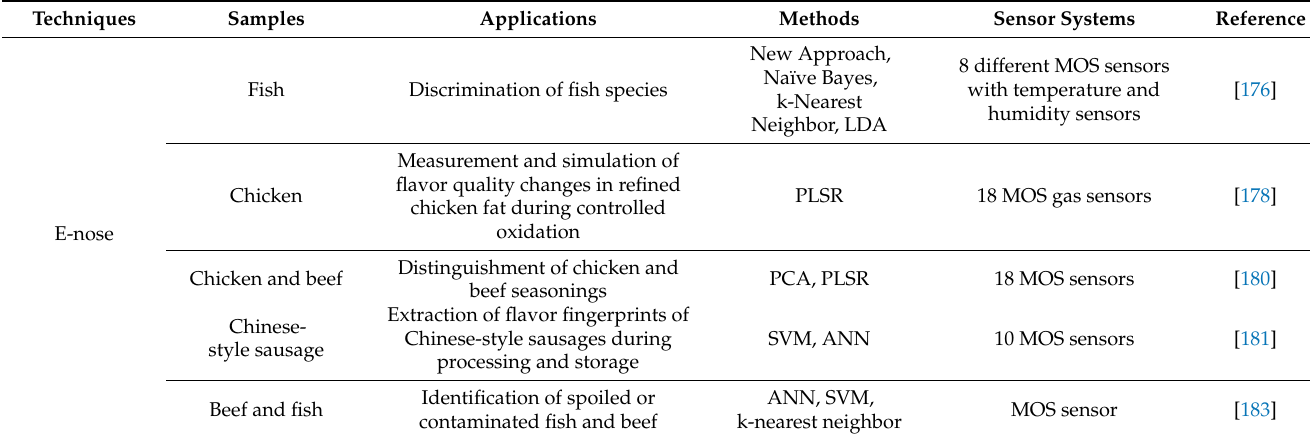
Table 5. Summaries of different sensors in electronic nose systems applied for meat